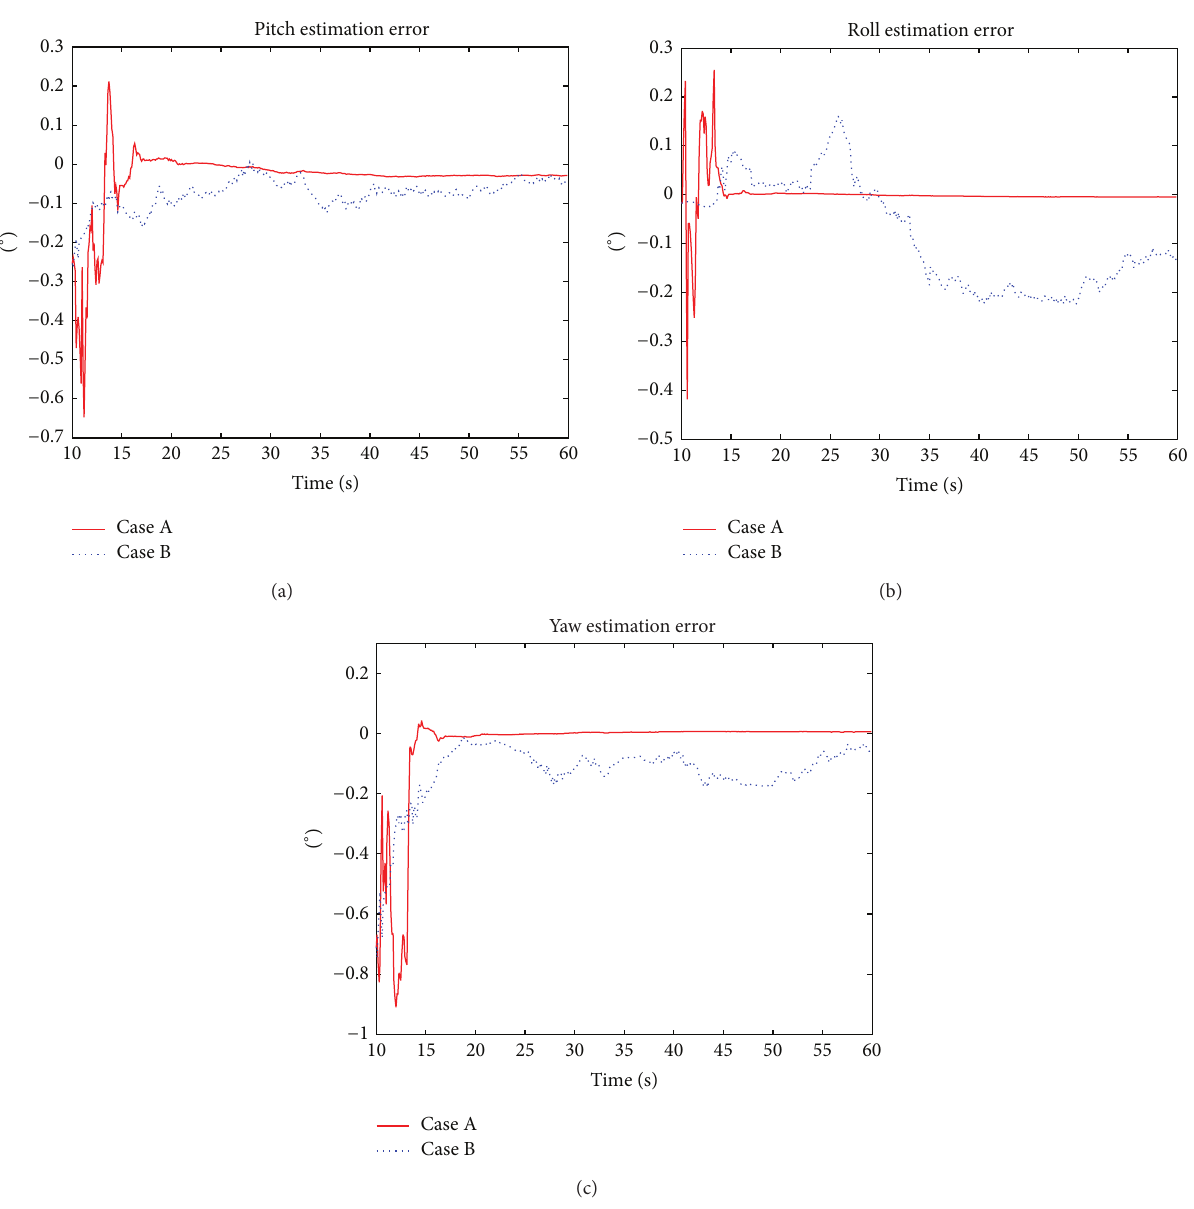
Figure 2: The attitude estimation error of second phase.